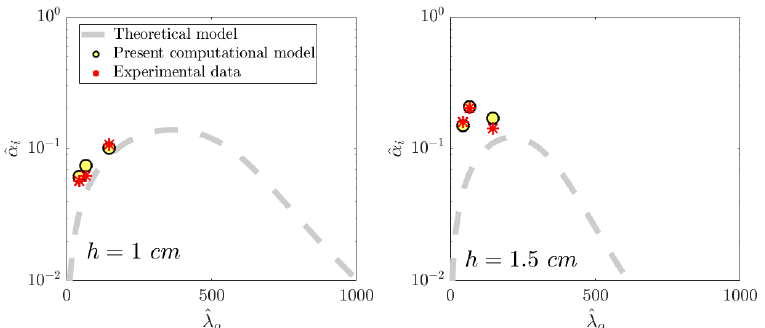
Figure 14. Comparison between decay rates given by the present computational model and the experimental values presented in Yiew et al. [53]. The dashed curves show the decay rate vs. open- water wavelength curves constructed by using Equation (5). Left and right panels respectively show the results corresponding to the ice covers with thicknesses of 1 and 1.5 cm.